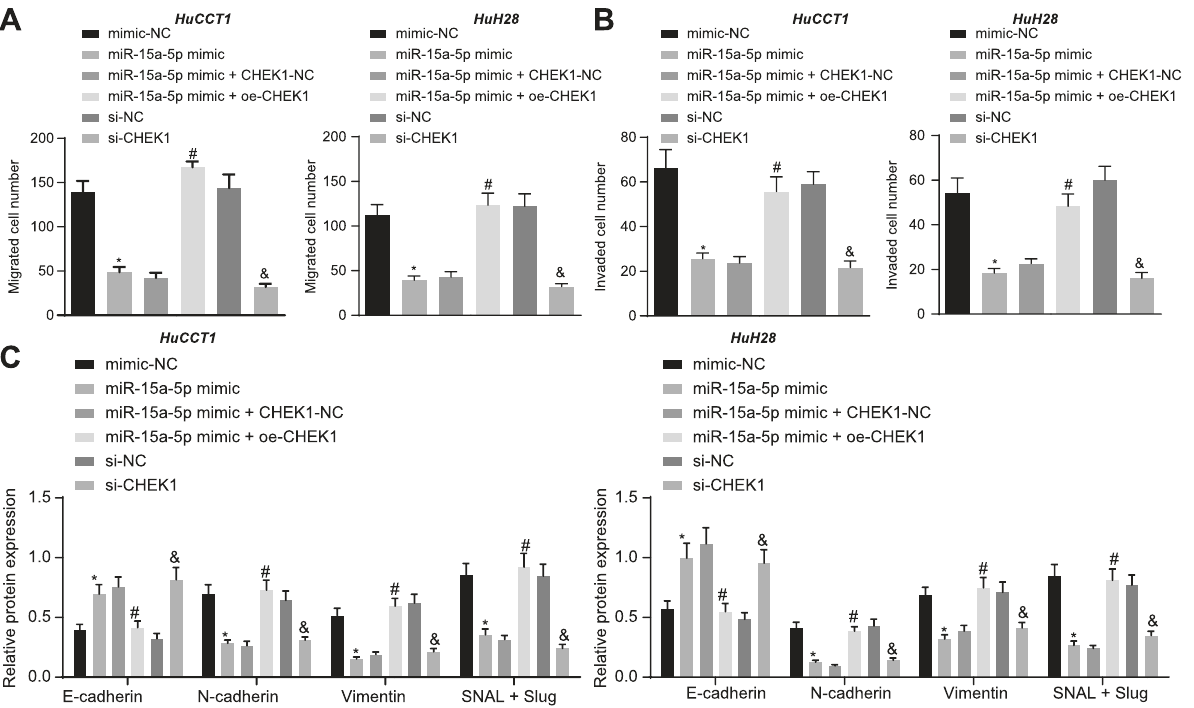
Fig. 4 miR-15a-5p suppresses the migration, invasion and EMT of CCA cells by targeting CHEK1. A Transwell assay of migration of HuCCT1 and HuH28 cells. B Matrigel-based Transwell assay of invasion of HuCCT1 and HuH28 cells. C Western blot assay of EMT related protein markers. In panels A-C, miR-15a-5p mimic, miR-15a-5p mimic + oe-CHEK1, si-CHEK1, and their corresponding controls were individually transfected into HuCCT1 and HuH28 cells. Cell experiments were repeated three times independently. The data are presented as mean ± standard deviation. The values at multiple groups were compared using one-way ANOVA followed by Tukey ’ s post-hoc tests; *means comparison against the mimic-NC group, P < 0.05; # means comparison against miR-15a-5p mimic + CHEK1-NC group, P < 0.05; & means comparison against the si-NC group, P <